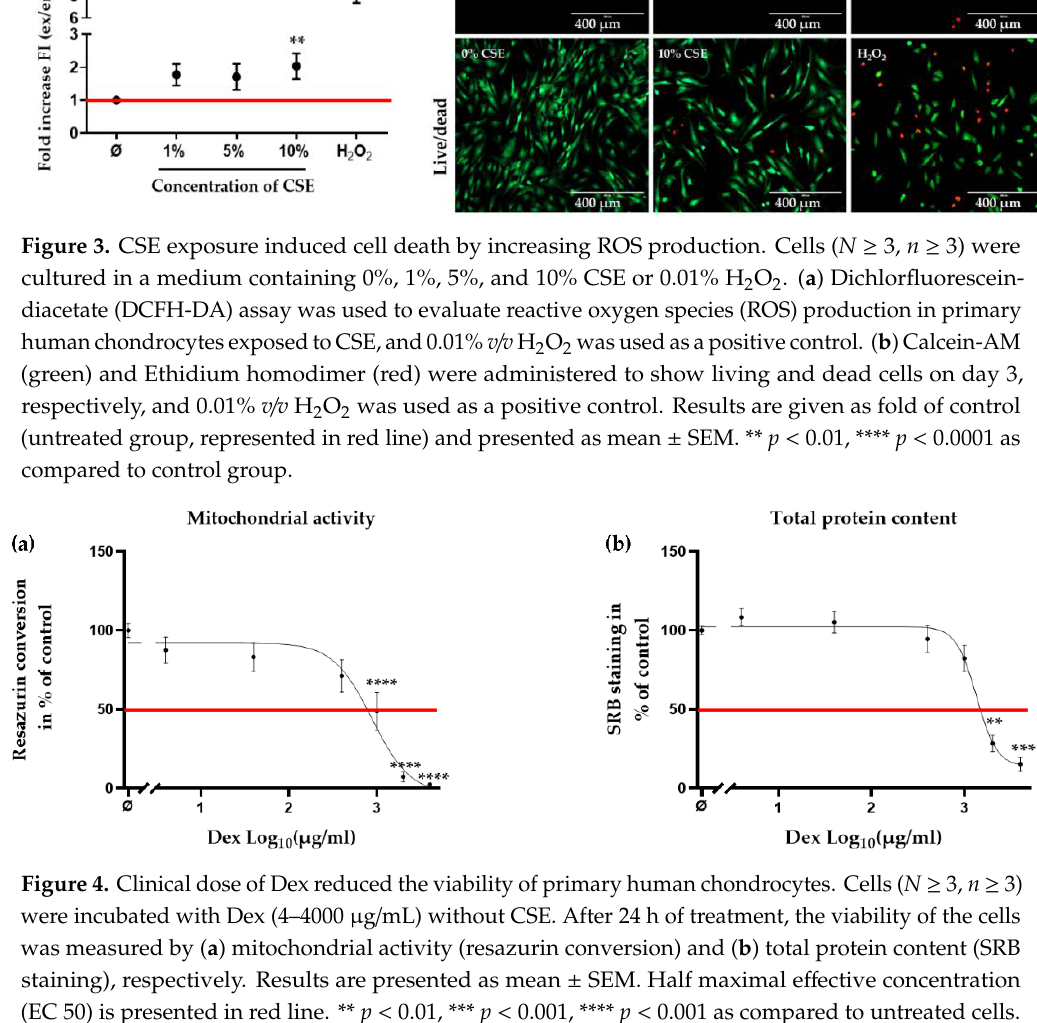
Figure 4. Clinical dose of Dex reduced the viability of primary human chondrocytes. Cells ( N ≥ 3, n ≥ 3) were incubated with Dex (4–4000 µ g / mL) without CSE. After 24 h of treatment, the viability of the cells was measured by ( a ) mitochondrial activity (resazurin conversion) and ( b ) total protein content (SRB staining), respectively. Results are presented as mean ± SEM. Half maximal e ff ective concentration (EC 50) is presented in red line. ** p < 0.01, *** p < 0.001, **** p < 0.001 as compared to untreated cells.